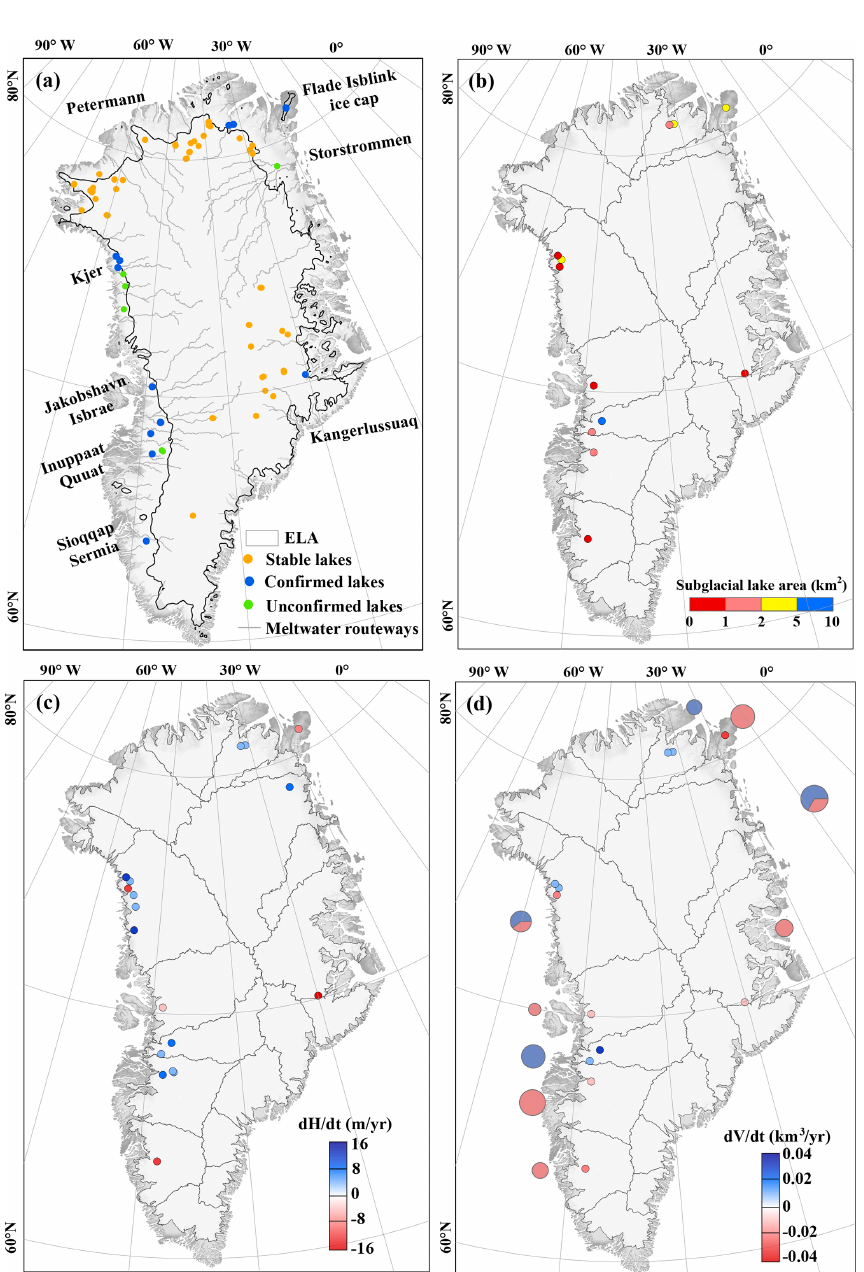
Figure 4. Maps of the (a) location, (b) area, (c) elevation-change rate, and (d) volume-change rate during the ICESat-2 period for the current active subglacial lakes under the Greenland Ice Sheet. The pie chart in panel (d) represents the overall volume-change rate of lakes in each basin (blue for positive, red for negative), and the pie size is proportional to the magnitude of the absolute rate. Meltwater pathways were derived from the hydraulic gradient (Livingstone et al., 2013). The equilibrium line altitude (ELA) was derived from daily MARv3.12.1 data (Fettweis et al., 2021). Stable lakes in (a) are from Livingstone et al. (2022).